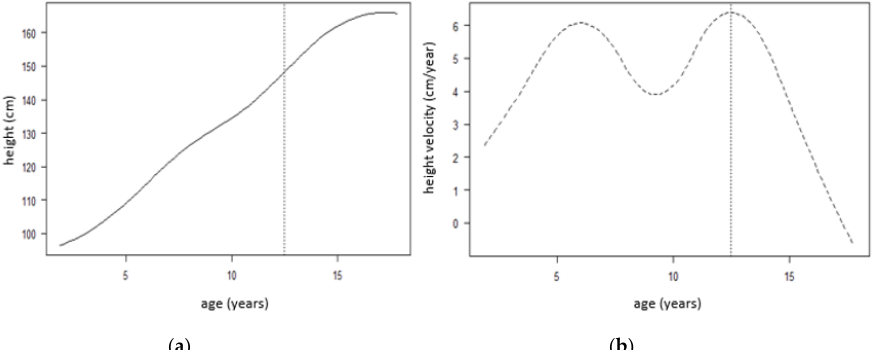
Figure 2. Superimposition by translation and rotation (SITAR) model mean growth curves for both boys and girls.